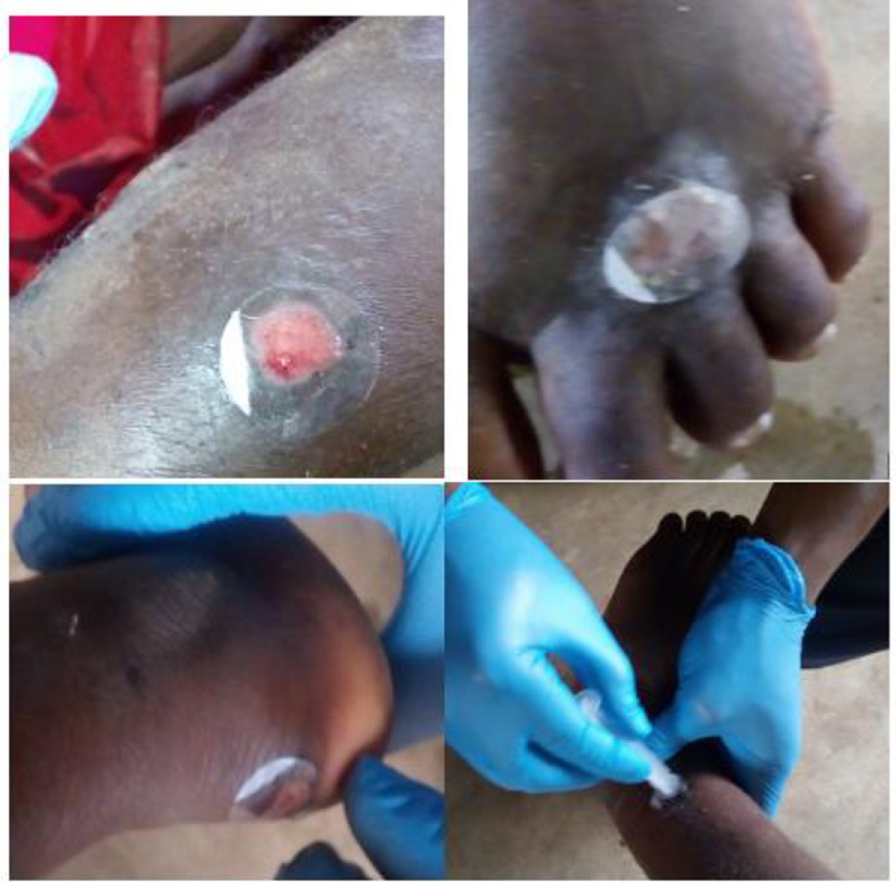
Fig 1. Non-invasive sampling of skin